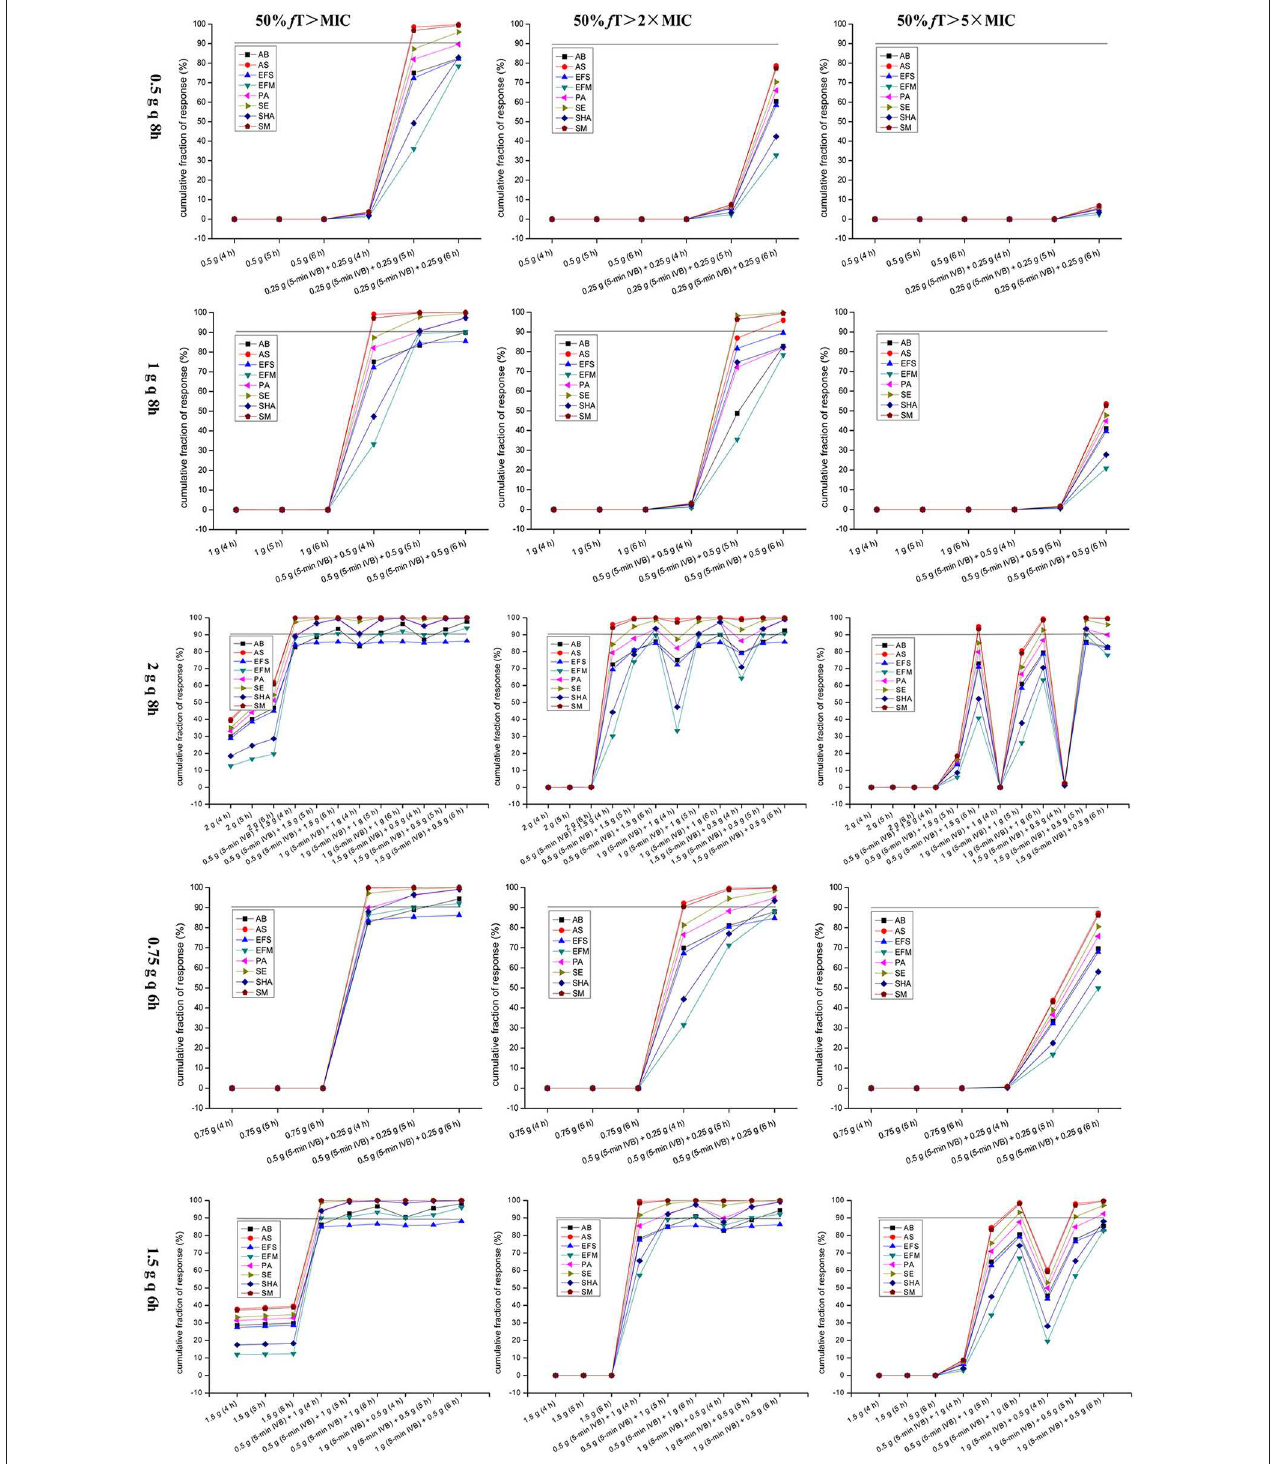
FIGURE 3 | CFRs of achieving 50% f T > MIC, 50% f T > 2 × MIC, and 50% f T > 5 × MIC for meropenem with various dosage regimens simulated for the targeted bacteria populations with pooled MIC distributions between 16 and 512 mg/L. AB, Acinetobacter baumannii ; AS, Acinetobacter spp.; EFS, Enterococcus faecalis ; EFM, Enterococcus faecium ; PA, Pseudomonas aeruginosa ; SE, Staphylococcus epidermidis ; SHA, Staphylococcus haemolyticus ; SM, Stenotrophomonas maltophilia ; 50% f T > MIC, 50% of the dosing interval during which free drug concentrations remain above the MIC; 50% f T > 2 × MIC, 50% of the dosing interval during which free drug concentrations remain above the MIC by two-fold; 50% f T > 5 × MIC, 50% of the dosing interval during which free drug concentrations remain above the MIC by five-fold.